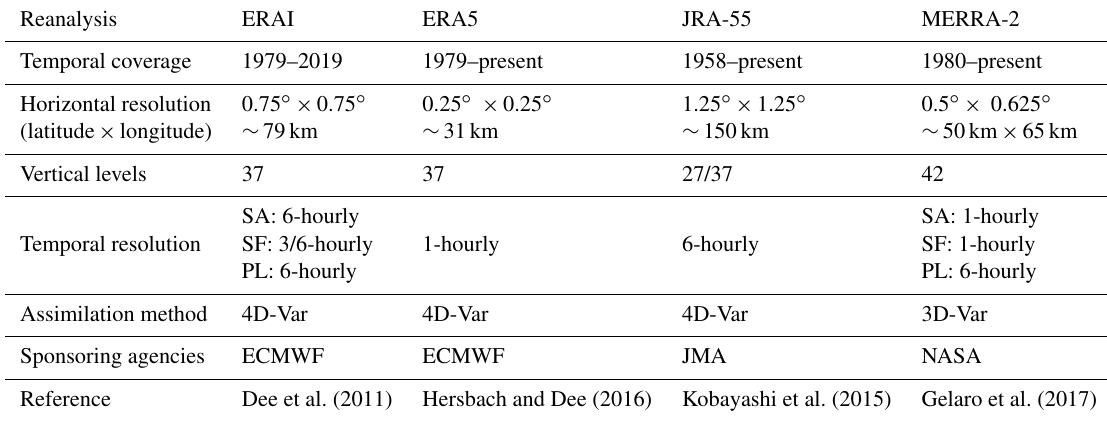
Table 1. Characteristics of the four reanalyses currently supported by